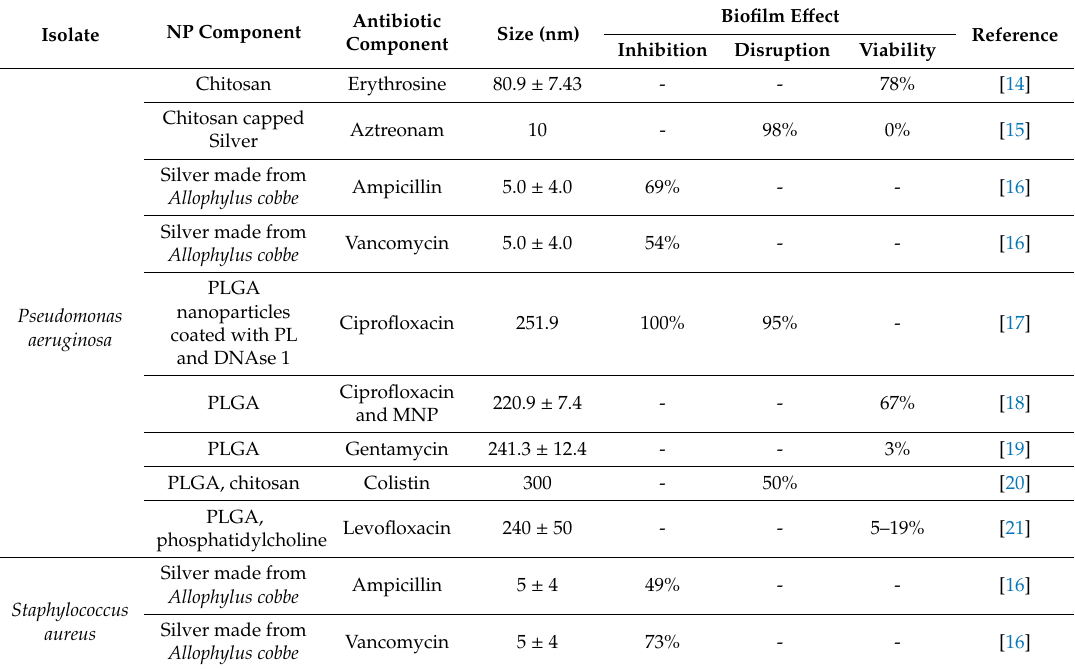
Table 1. Summary of CF-related in vitro biofilms treated with antibiotic + nanoparticles combinations.